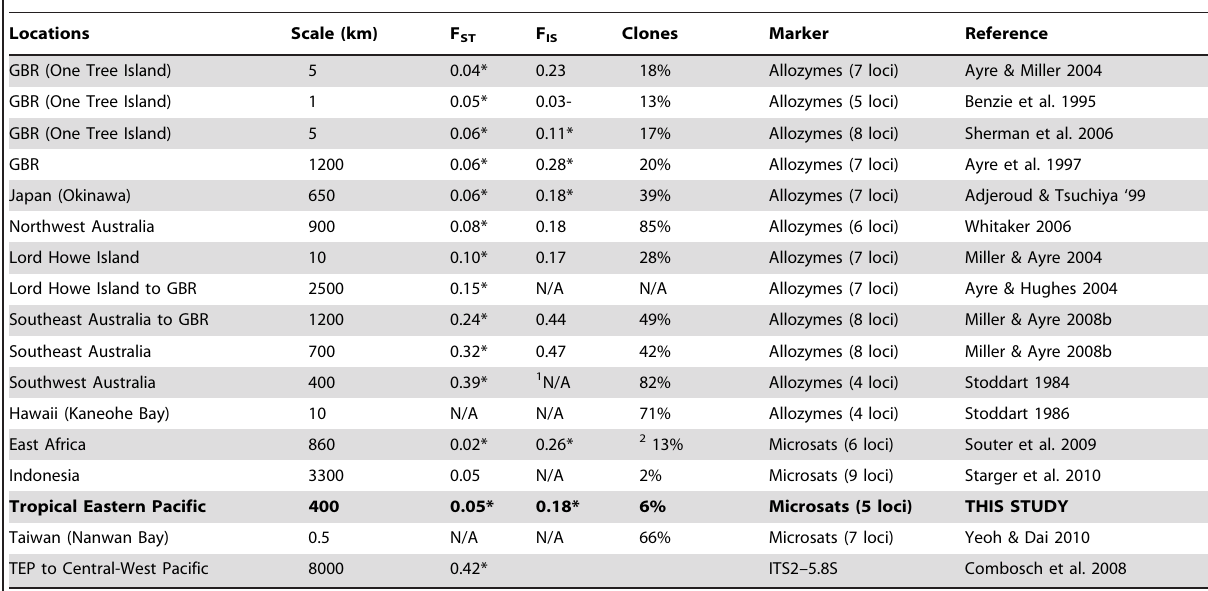
Table 5. Pocillopora damicornis population genetic survey (sorted by F ST ).